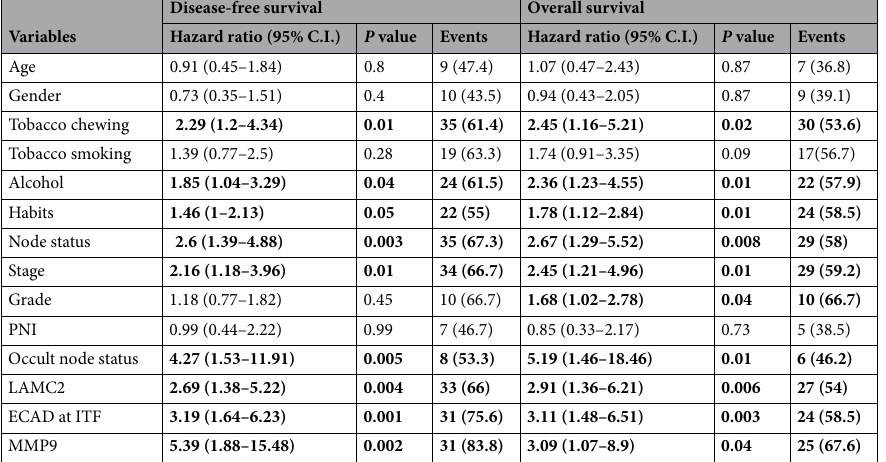
Table 5. Univariate survival analysis for disease-free and overall survival in all patients. Factors denoting increased hazard of death and recurrence in OTSCC; Numbers in brackets denote percentages. The numbers in bold denote values that are of statistical significance.